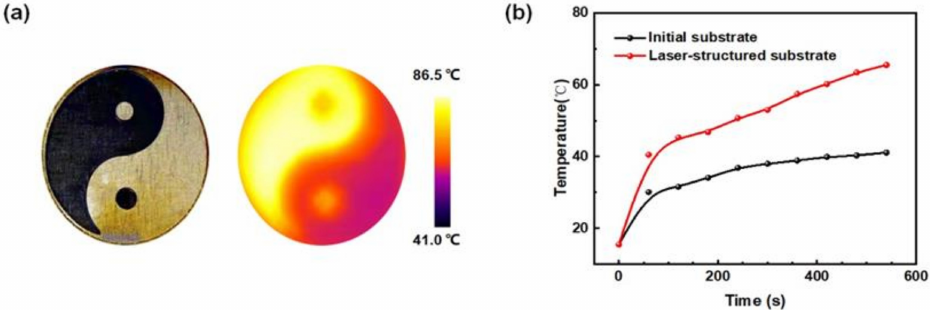
Figure 6. ( a ) Thermal imaging of initial titanium alloy and laser-treated titanium alloy substrate. ( b ) Dependence of the surface temperature on irradiation time for initial titanium alloy and laser- treated titanium alloy